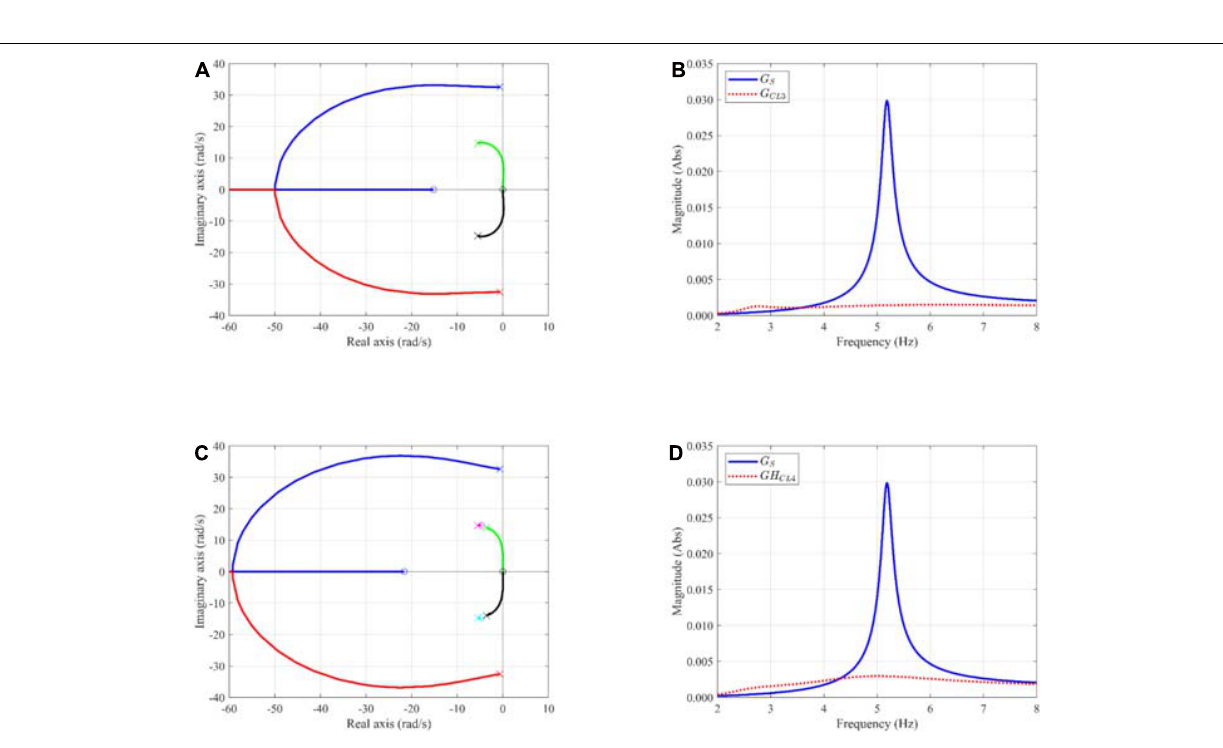
Frontiers in Built Environment |